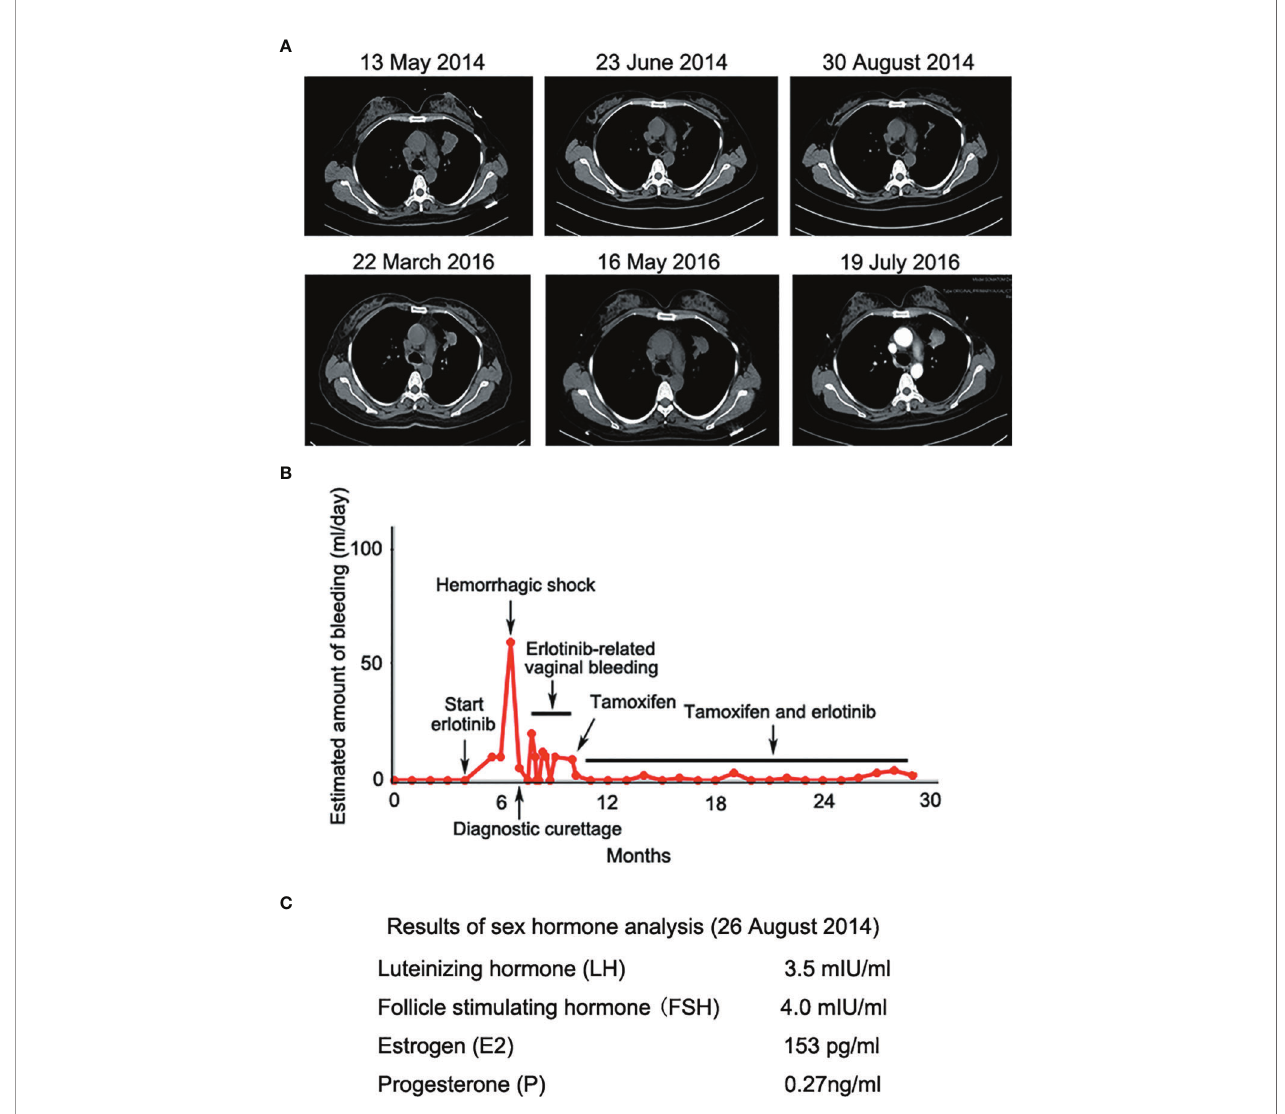
FIGURE 2 | (A) Erlotinib decreased lesion in the upper lobe of the left lung signi fi cantly at the early stage of treatment; (B) Erlotinib-related vaginal bleeding during the treatment; (C) Sex hormone tests showed low levels of progesterone during luteal stages of the menstrual